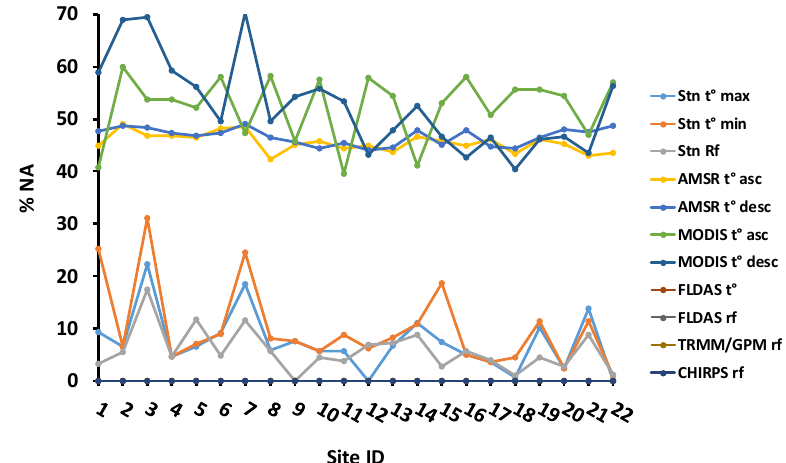
Figure 2. Percentage of daily missing data (% NA) of temperature and rainfall for 2003–2016. Note that Site ID in this figure corresponds to station labels in Figure 1 and Table 2. Note also that station, AMSR, and MODIS temperature are measured daytime and nighttime while the rest of the variables are daily. Note that the % NA values are zero at all sites for FLDAS, Tropical Rainfall Measurement Mission / Global Precipitation Mission (TRMM / GPM), and CHIRPS.